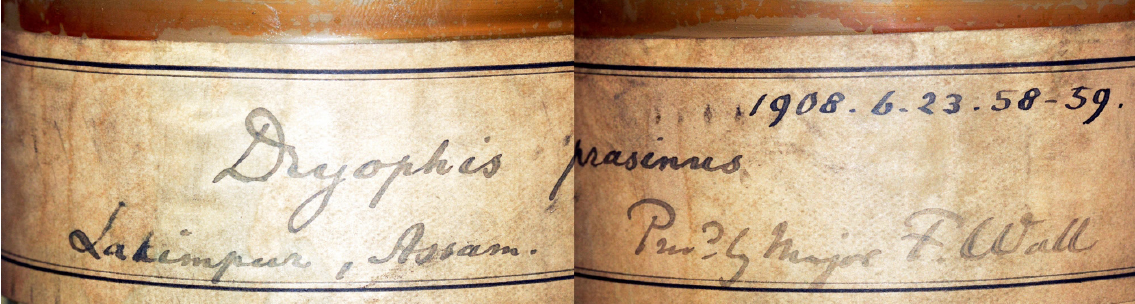
Fig. 6. Dryophis prasinus var . flavescens Wall, 1910, lectotype (NHMUK 1908.6.23.58) and paralectotype (NHMUK 1908.6.23.59). Jar label . Photo: © The Trustees of the Natural History Museum,